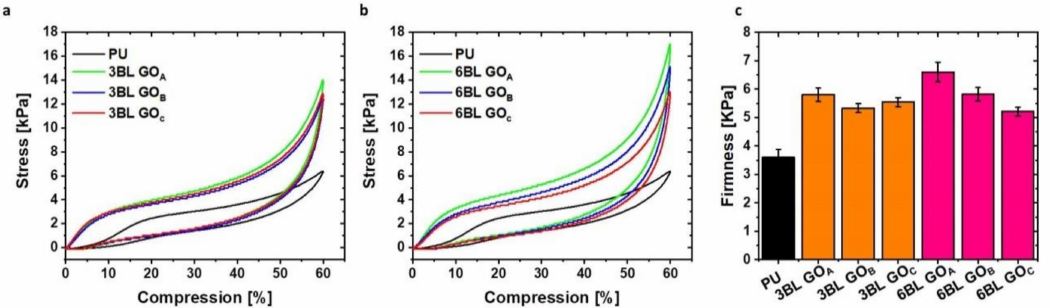
Figure 7. Mechanical compression test performed on 3BL ( a ) and 6BL ( b ) treated PU foams. Firmness comparison of different treated samples ( c